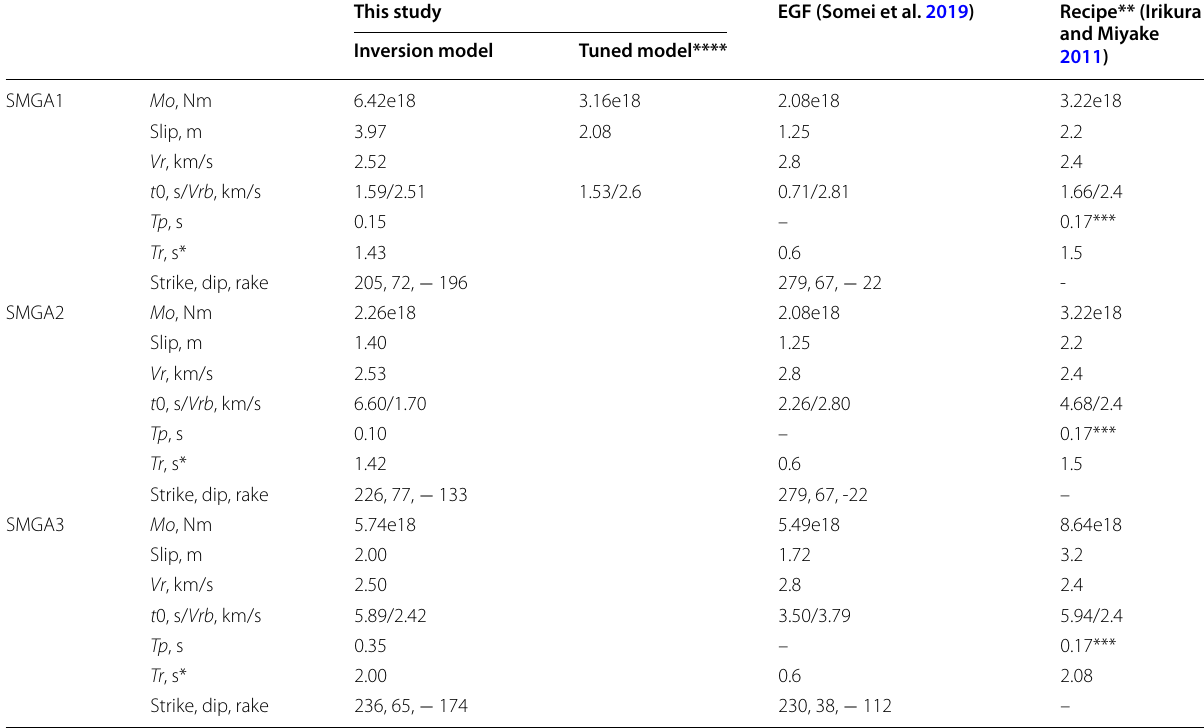
Table 4 SMGA parameters in this study and comparison with Somei et al. (2019), and Recipe. For location of SMGAs and hypocenters, see Fig.